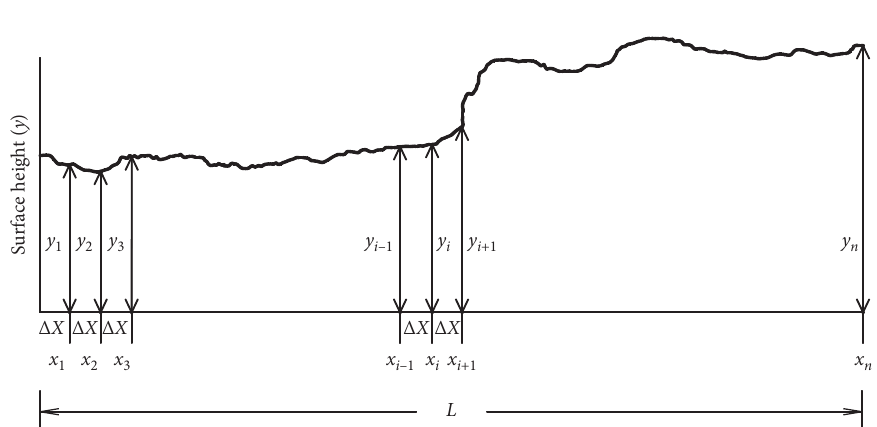
Figure 2: The diagram used to define geometric coordinates of a joint profile [12].